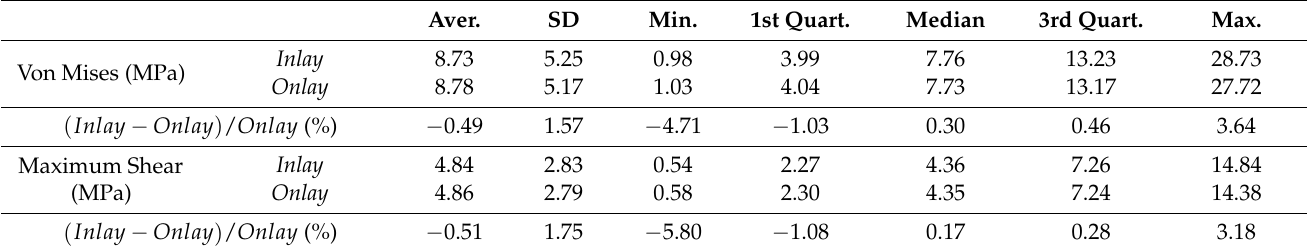
Table 6. Statistical description of the stress distributions for the “bed” resin cement adhesives. Aver. SD Min. 1st Quart. Median 3rd Quart. Max.